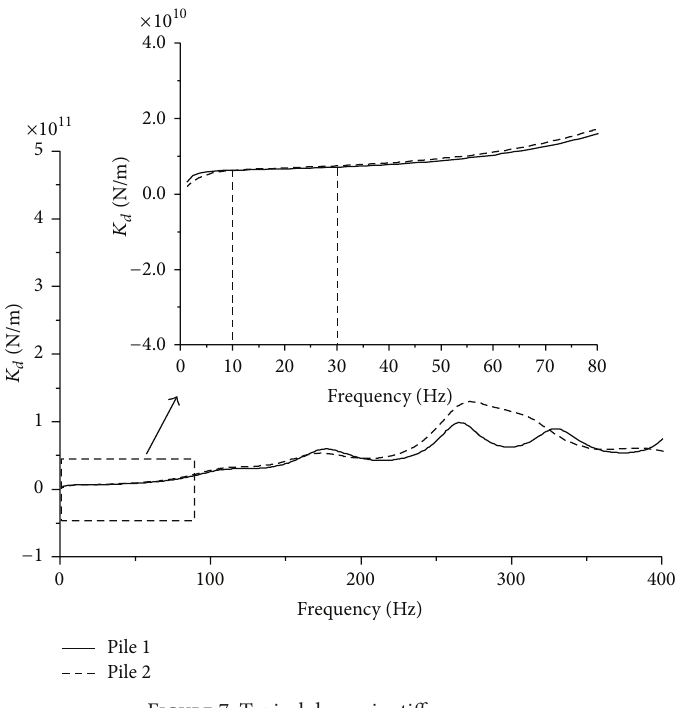
Figure 7: Typical dynamic stiffness curves.